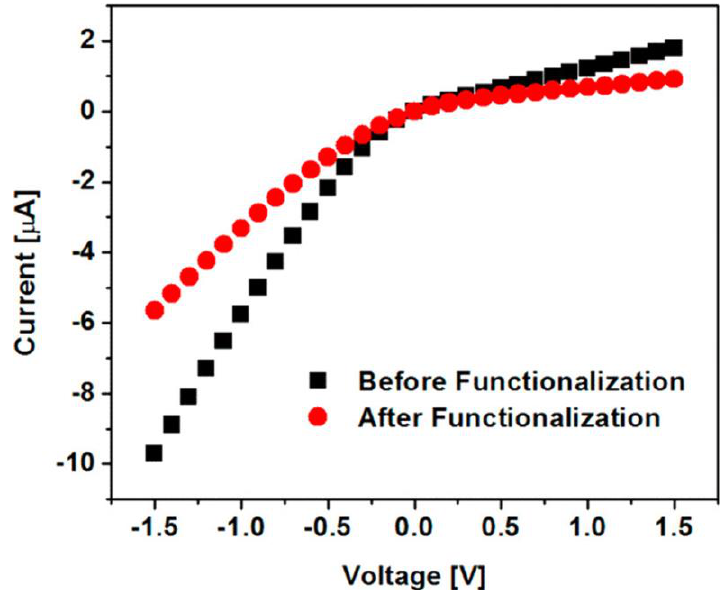
Figure 10. I–V curves for conical pore membranes before and after pore-wall functionalization with 18-crown-6. The electrolyte in both the receiver and feed solution was 10 mM LiCl and 5 mM Tris-HCl (pH 7.0). Reprinted with permission from [13]. Copyright 2018, American Chemical Society.